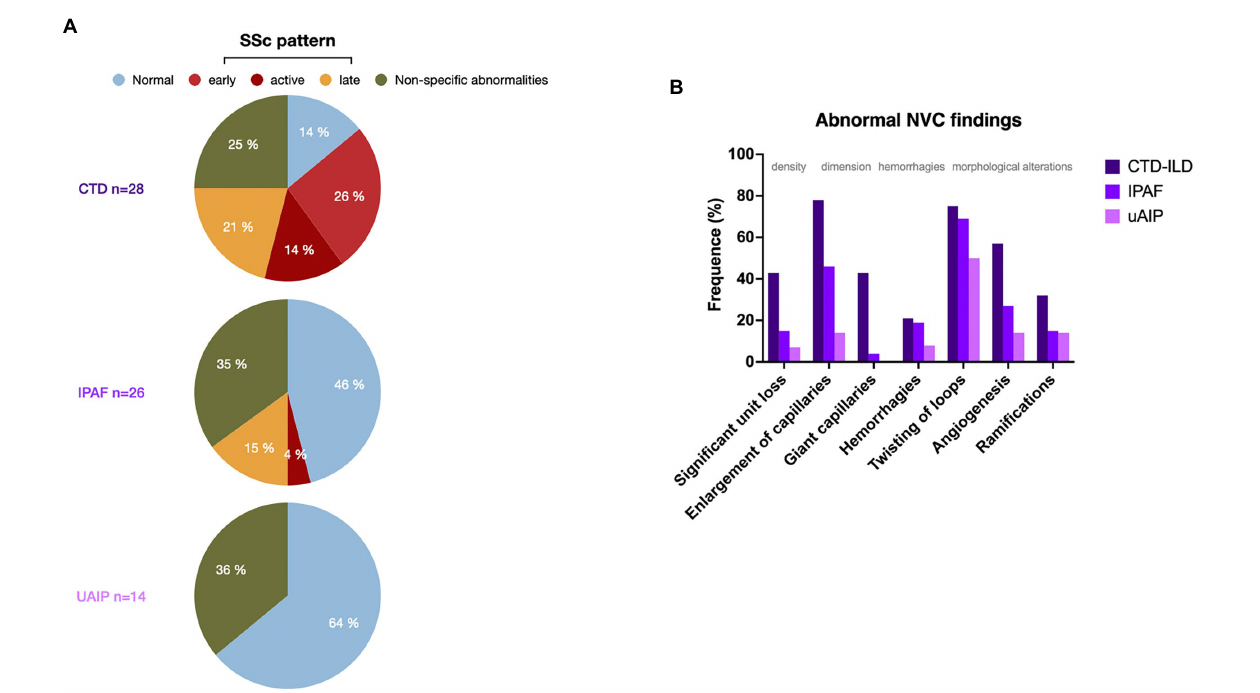
FIGURE 1 (A) Patterns of nailfold videocapillaroscopy (NVC) in the three diagnostic groups shown as percentage of the studies performed. (B) Distribution of nailfold videocapillaroscopy (NVC) abnormalities in the patients from the 3 diagnostic groups shown as percentage of the studies performed. SSc: systemic sclerosis. CTD: connective tissue disease, IPAF: interstitial pneumonia with autoimmune features. uAIP: undifferenciated autoimmune interstitial pneumonia. ILD: interstitial lung